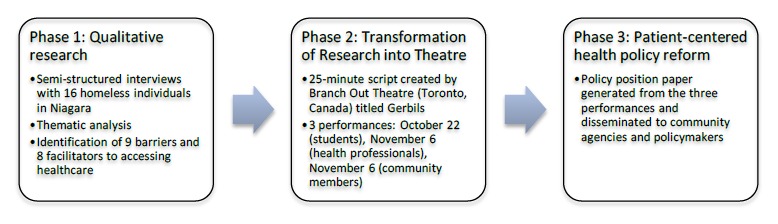
HEART framework